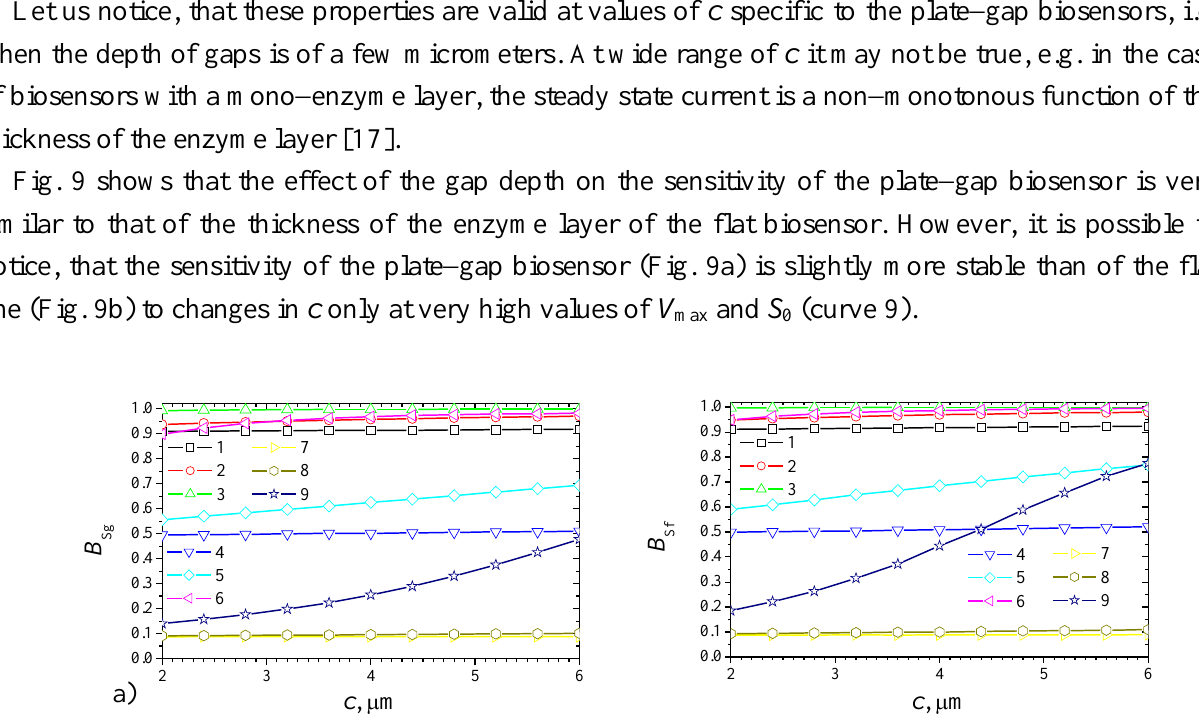
Figure 9 . The normalized biosensor sensitivity vs. the gap depth c of the plate − gap biosensor (a) and the thickness of enzyme layer of the flat one (b), δ = 2 µ m. Other parameters and the notations are the same as in Fig.